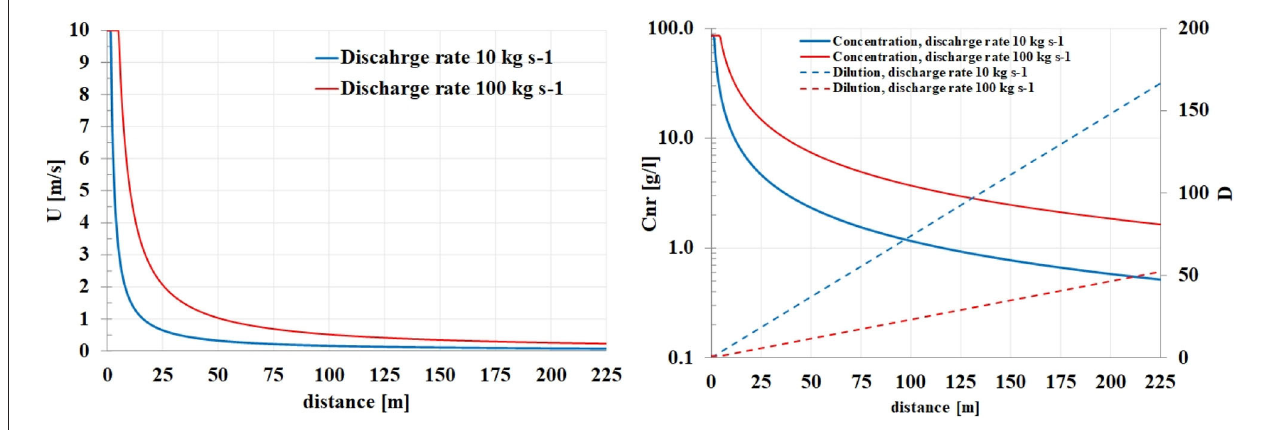
FIGURE 4 | Velocity of the flow (left plot), concentration of a non-reactive substance discharged in the wake (right plot, line) and dilution rate (right plot, dotted line), for two discharge